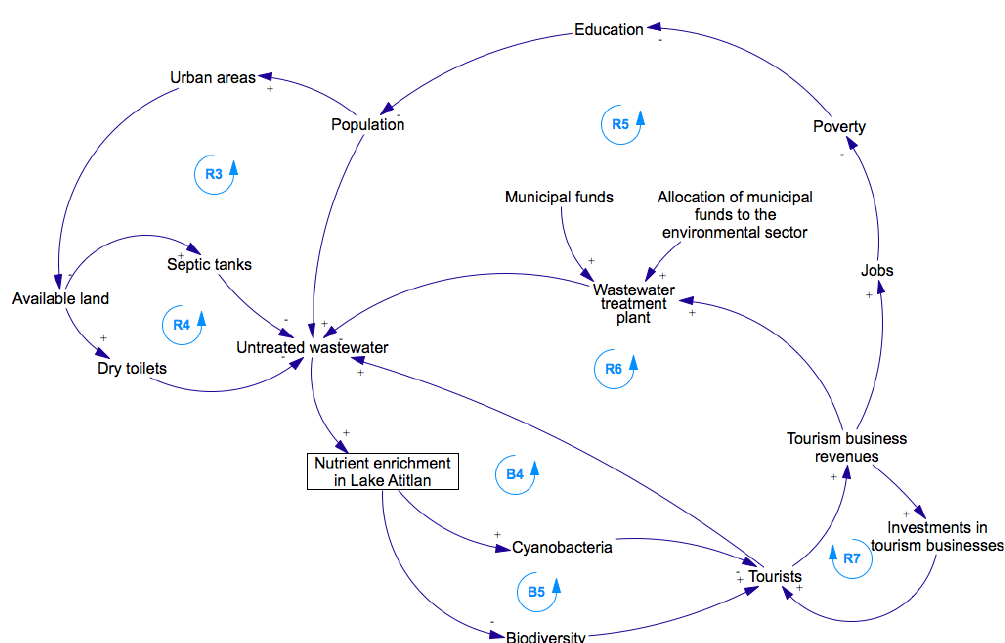
Figure 9. Tourism